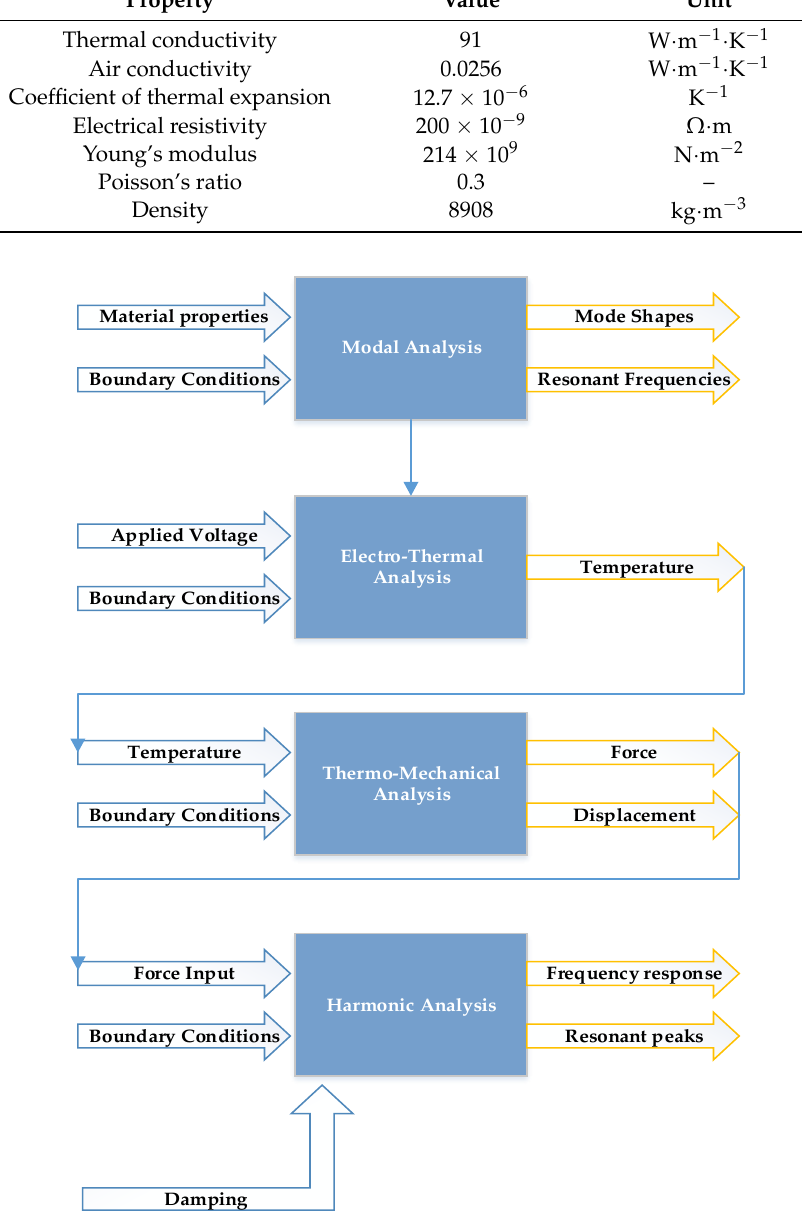
Figure 13. The sequential diagram for the FEM-based analysis.